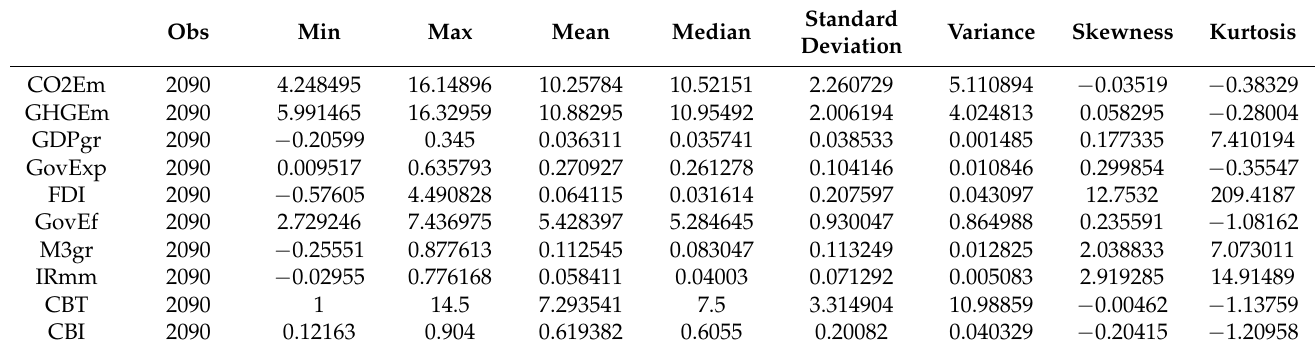
Table 2. Descriptive